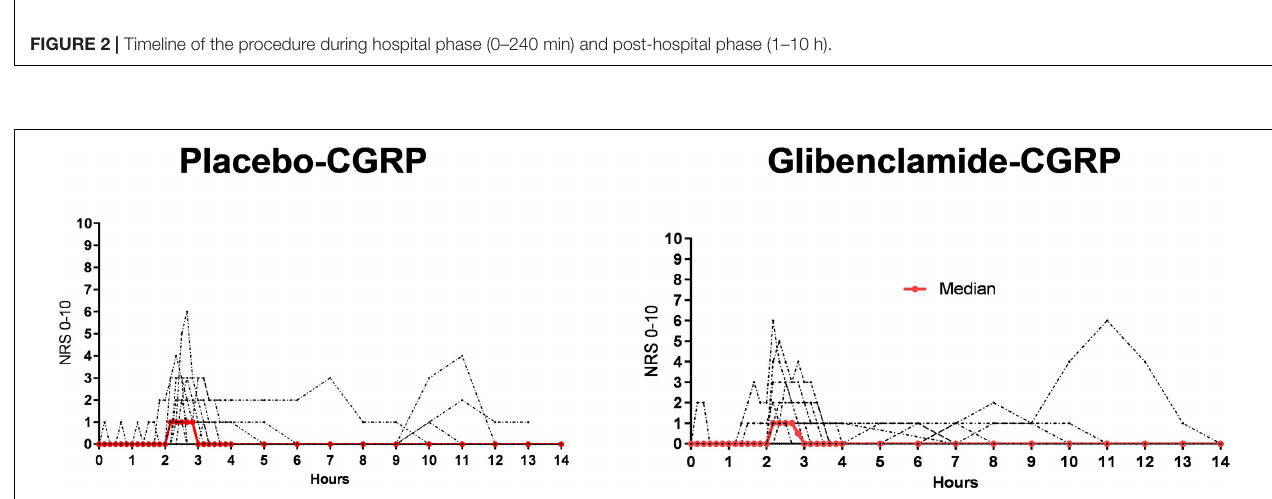
FIGURE 3 | Individual (black lines) and median (red line) headache intensity after glibenclamide and placebo, n = 20. All participants received CGRP-infusion at 120 min. On glibenclamide-CGRP day 14 reported headache and on placebo-CGRP day 19 participants reported headache. We found no difference in headache incidence and intensity between glibenclamide-CGRP and placebo-CGRP day ( P = 0.06).